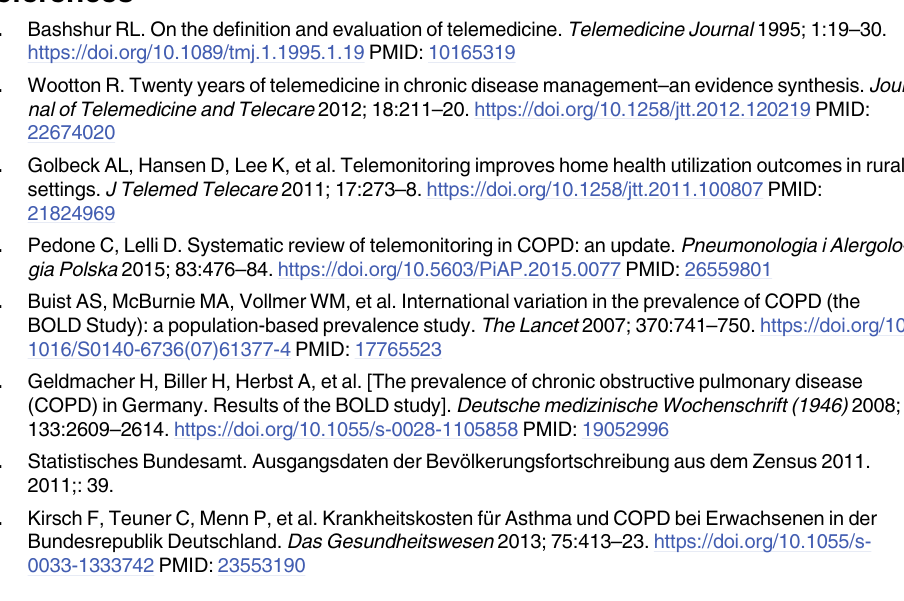
S1 Table. Reasons for refusal of telemonitoring services. S2 Table. Detailed information about differences in comorbidity between